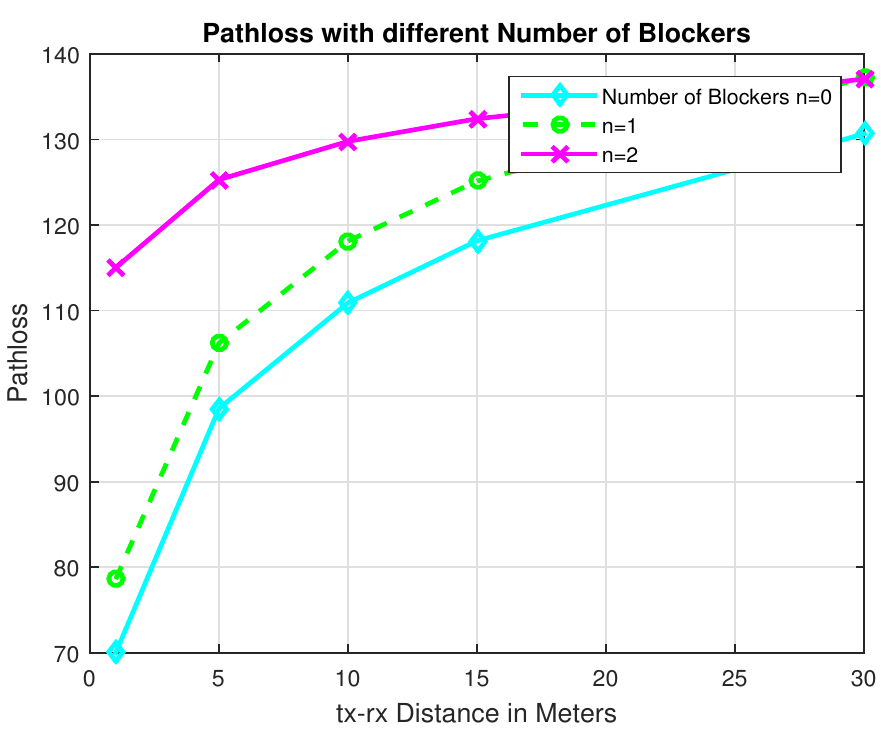
Figure 4. Pathloss in the presence of